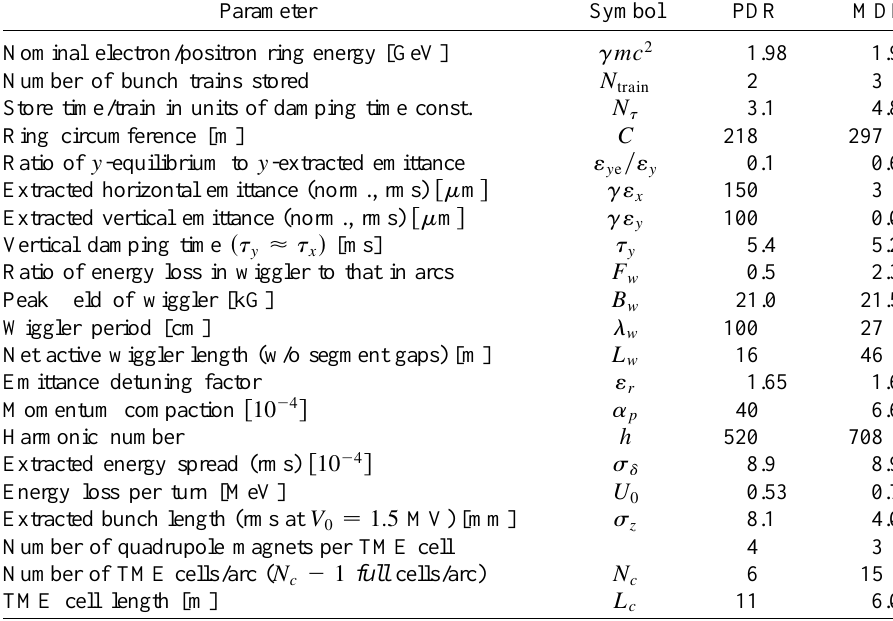
TABLE II. List of NLC MDR and PDR parameters for the collider parameters of Table I. Parameter Symbol PDR Nominal electron/positron ring energy [GeV] Number of bunch trains stored